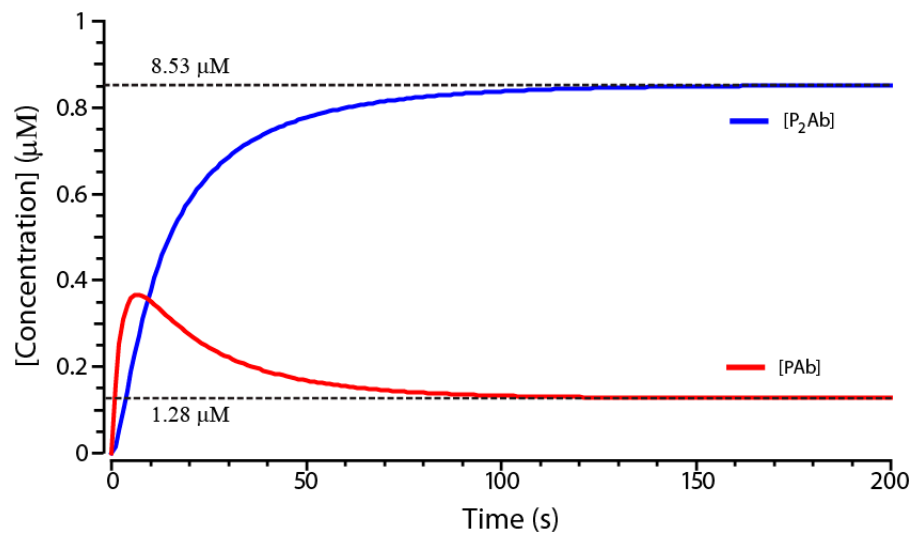
7 of 16 Figure 2. The system of differential equations describing the serodiagnostic lateral flow system with two antigens. k1— kinetic constants of association of the corresponding reaction, k2—kinetic constants of dissociation of the corresponding reaction, h —Heaviside function. 3.2. Formation of PAb and P 2 Ab Complexes The antibody detection sensitivity in the considered depends on the ratio of [PAb] and [P 2 Ab] concentrations. As the P 2 Ab complex does not have free valences for the for- mation of a detectable PAbAg complex, the formation of P 2 Ab is an undesirable process. For highly sensitive detection of antibodies in a sample, it is necessary to run the assay under conditions that maintain high [PAb] and low [P 2 Ab] concentrations. The system simulated in the COPASI program for arbitrarily chosen concentrations [Ab] 0 and [P] 0 gives the kinetic curves of PAb and P 2 Ab formation shown in Figure 3. From the data obtained, it follows that, for the given parameters, the concentration [PAb] will approach the equilibrium value by 90% in 76 s. At the same time, the concentration of